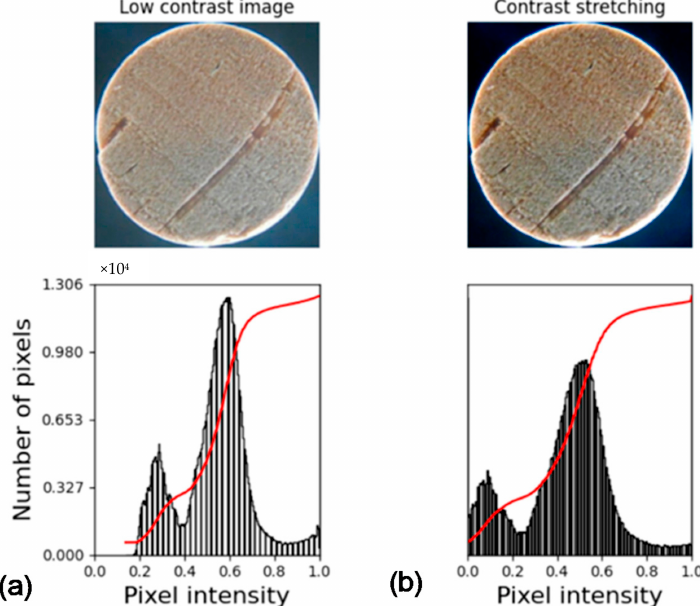
Figure 2. Example of contrast stretching. Image and histogram: ( a ) without stretching; ( b ) with